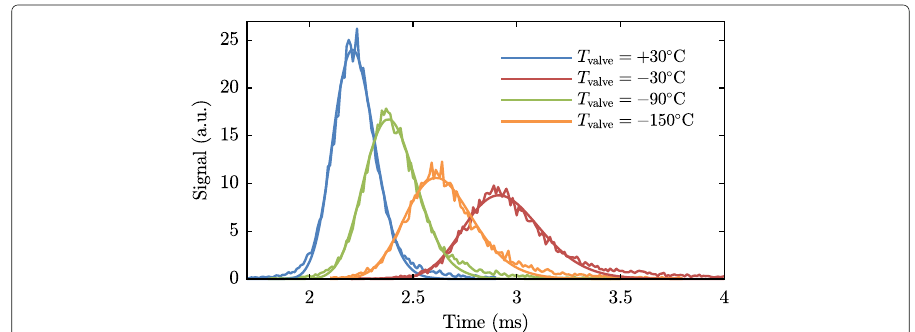
Fig. 8 Argon time-of-flight measurements (with fits) in detection zone II at the different valve temperatures for the purpose of argon beam intensity calibration